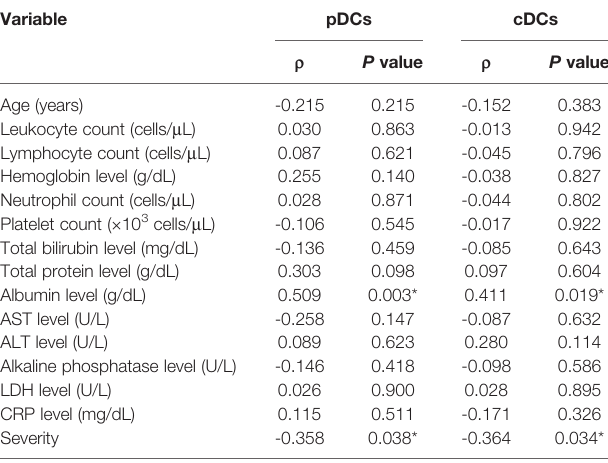
TABLE 2 | Spearman ’ s correlation coef fi cients for the percentages of pDCs and cDCs with respect to clinical and laboratory parameters in 35 patients with scrub typhus. Variable